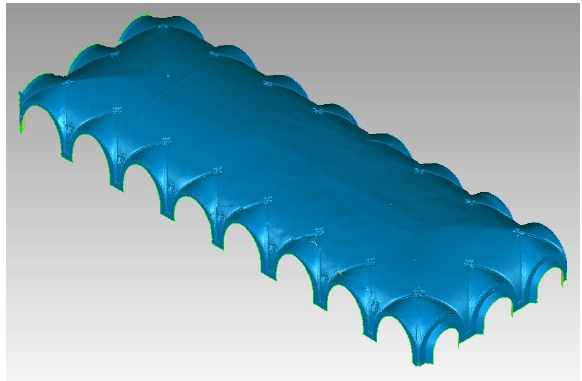
Figure 5. The 3D geometrical model